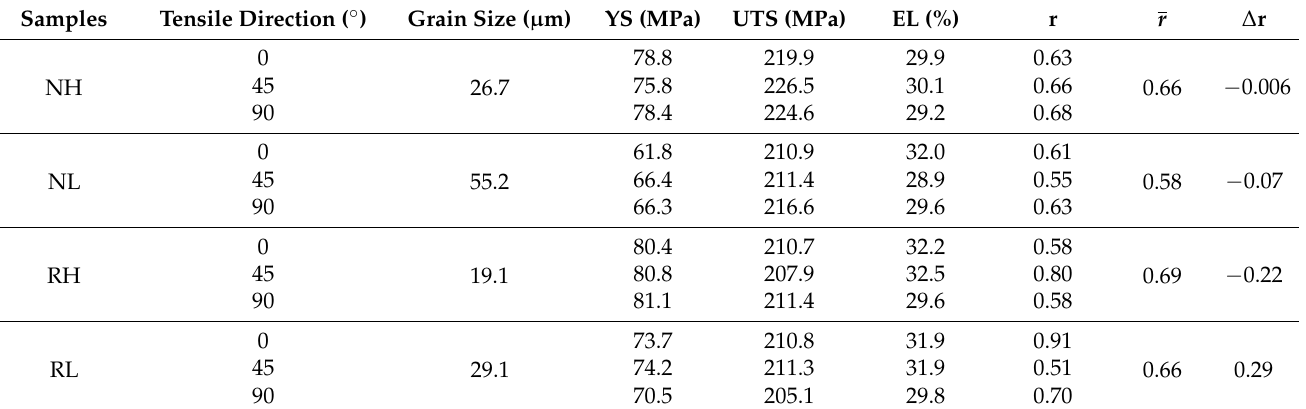
Table 2. Recrystallized grain size, YS, UTS, EL, r , and ∆ r of the NH, NL, RH, and RL recrystallized sheets corresponding to the tensile directions of 0, 45, and 90 ◦ with respect to the